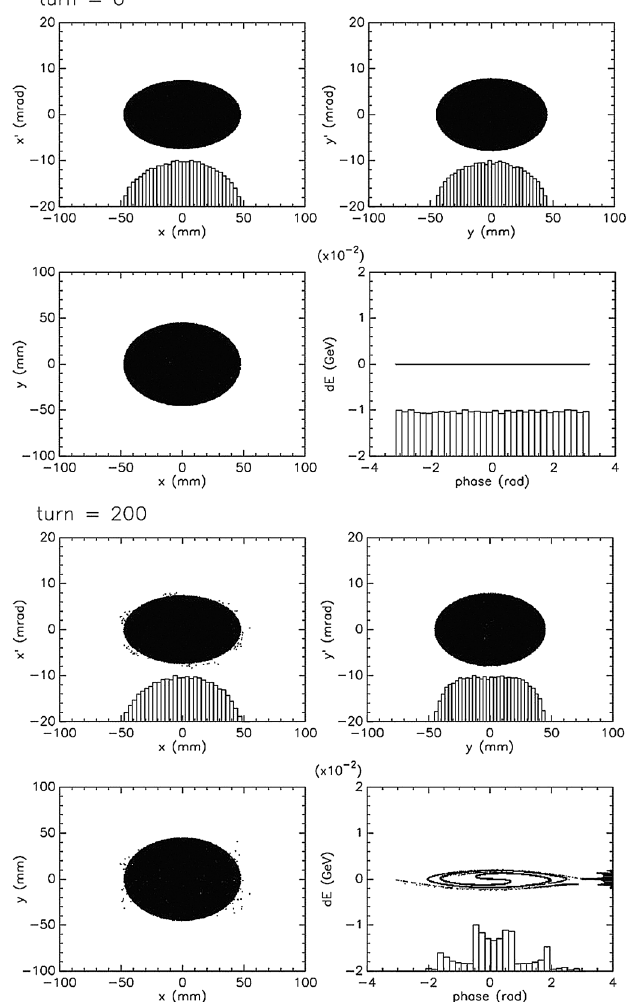
FIG. 12. Distributions in the phase spaces with one-turn injec- tion and after some turns at the injection point with an anti- correlated beam. The injection energy is 80 MeV. Upper: at injection; lower: after 200